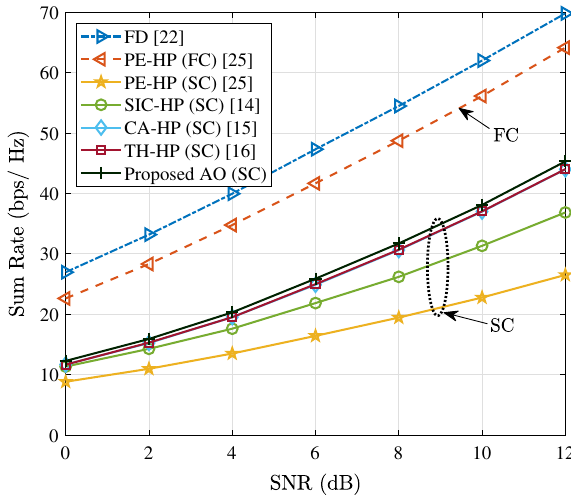
Fig. 2 Sum rate versus SNR. We set N t = 60 and K = M =